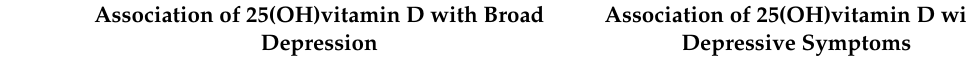
Table 2. Results of the Mendelian Randomization analyses on the associations of natural-log transformed 25(OH)vitamin D concentrations with broad depression and depressive